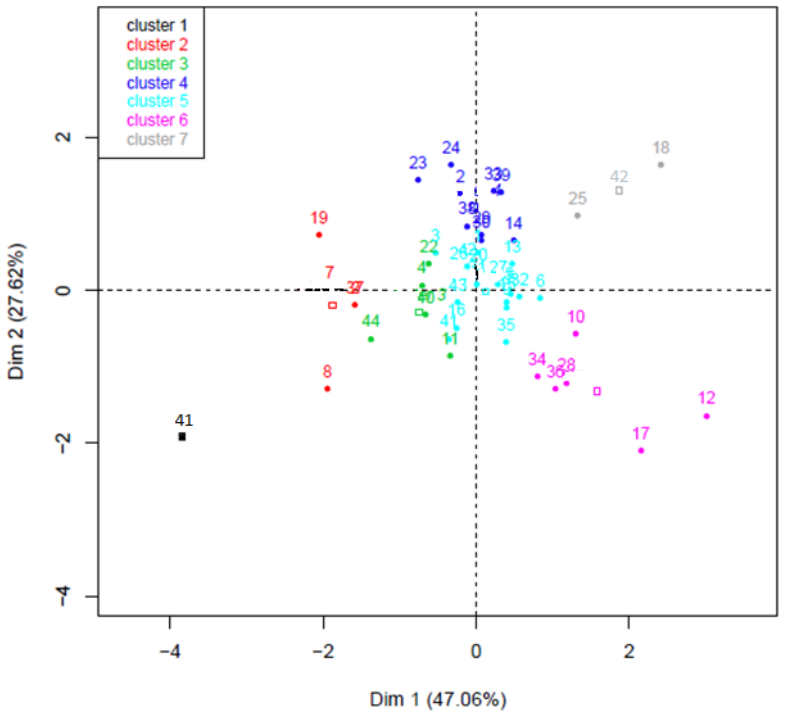
Figure 4. Hierarchical clustering on principal components analysis using seed trait parameters Ψ b, Tb and Ki of the 44 genotypes. Genotypes are represented by numbers , according to Table 1.